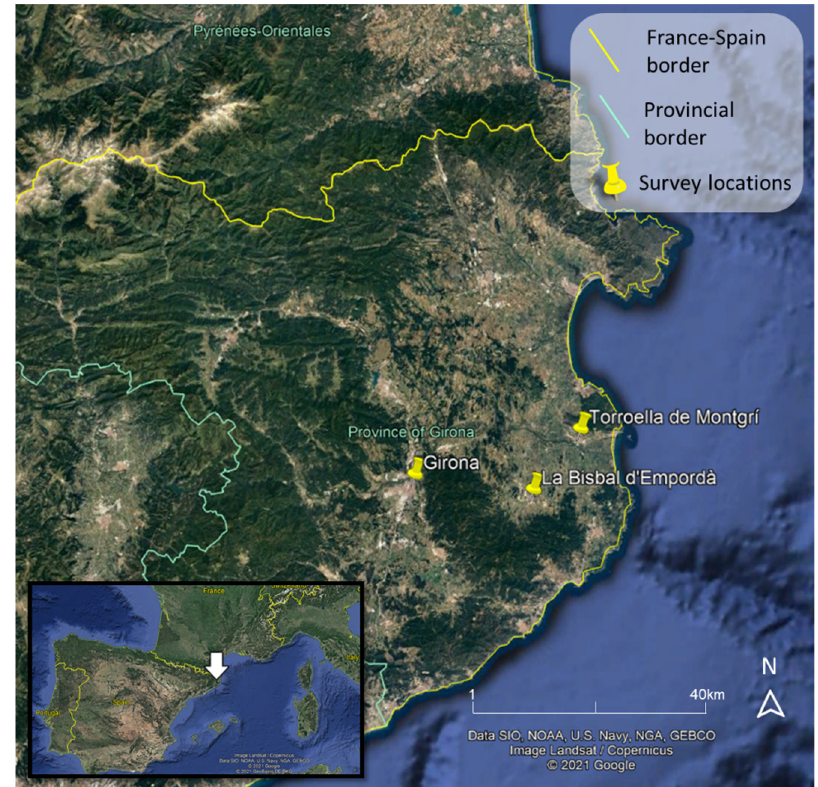
Figure 1. Location of the three data collection municipalities .